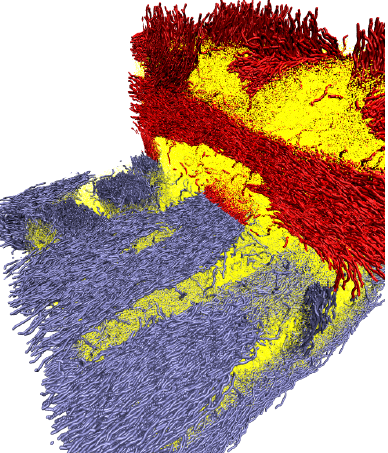
Figure 6. Three-dimensional cross-section of an instantaneous polymer configurations in the phase separated state, stiff polymer chains are shown in red and blue, segments of flexible chains are shown as yellow dots to facilitate visualization [45].